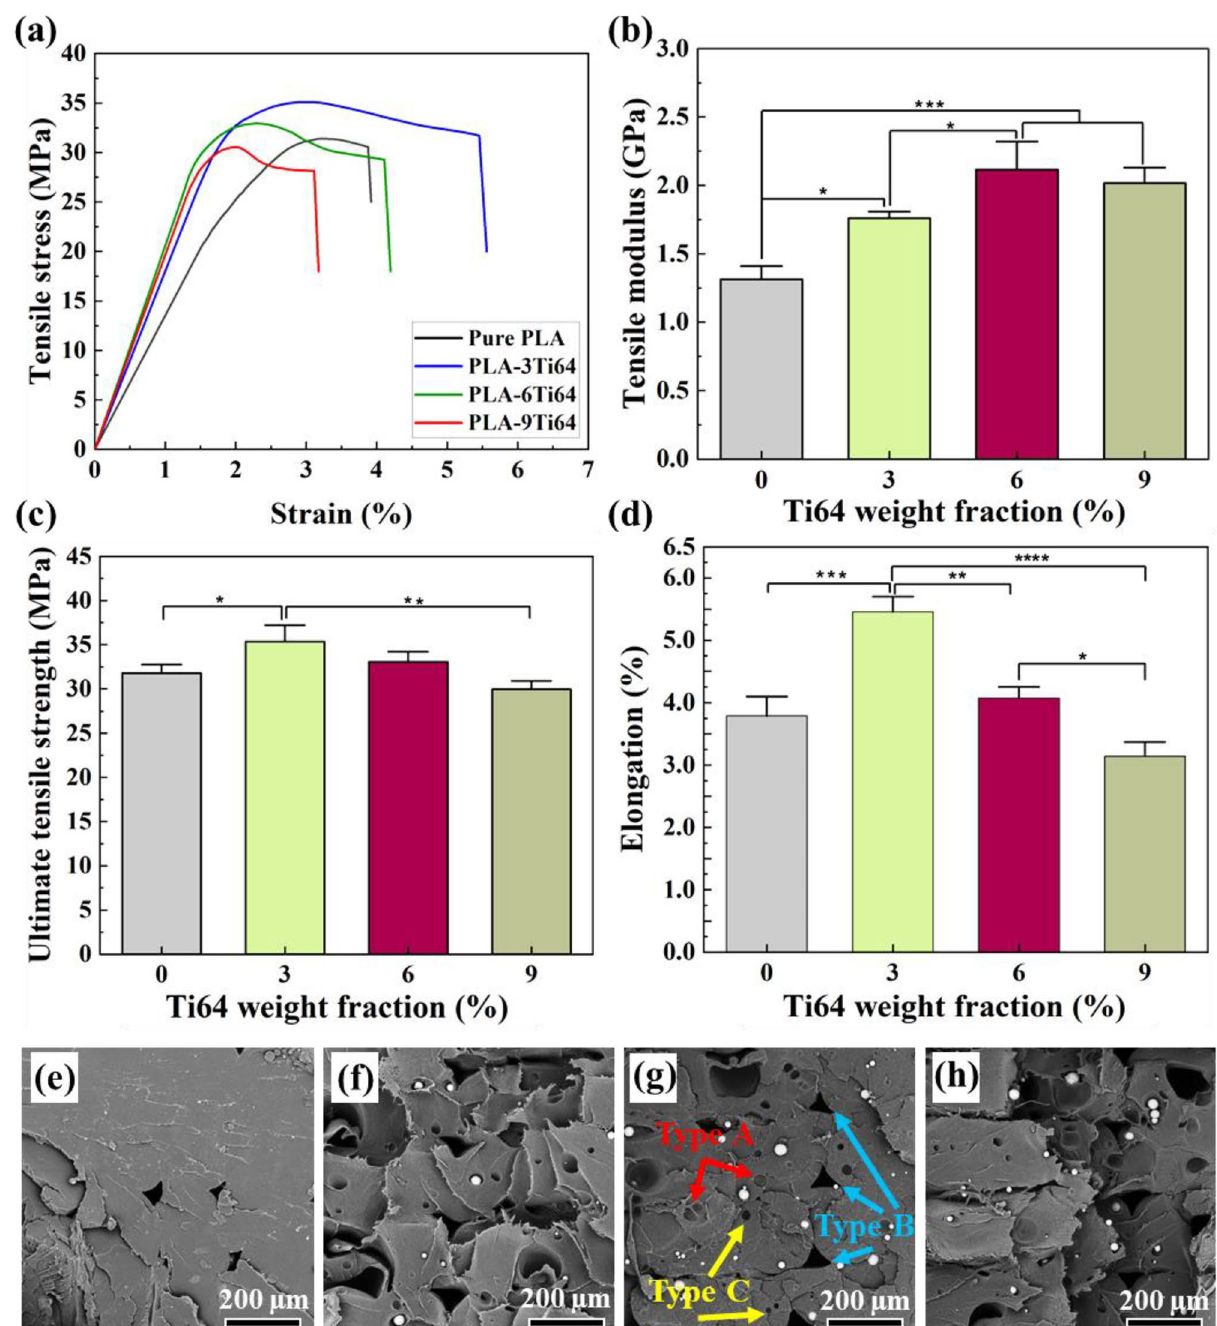
Figure 5. Tensile curves ( a ), tensile modulus ( b ), ultimate tensile strength ( c ), and elongation ( d ) of PLA/ Ti64 composite scaffolds (* p < 0.05, ** p < 0.01, *** p < 0.001, **** p < 0.0001). FESEM micrographs from fracture surfaces of pure PLA ( e ), PLA-3Ti64 ( f ), PLA-6Ti64 ( g ) and PLA-9Ti64 ( h ) scaffolds.